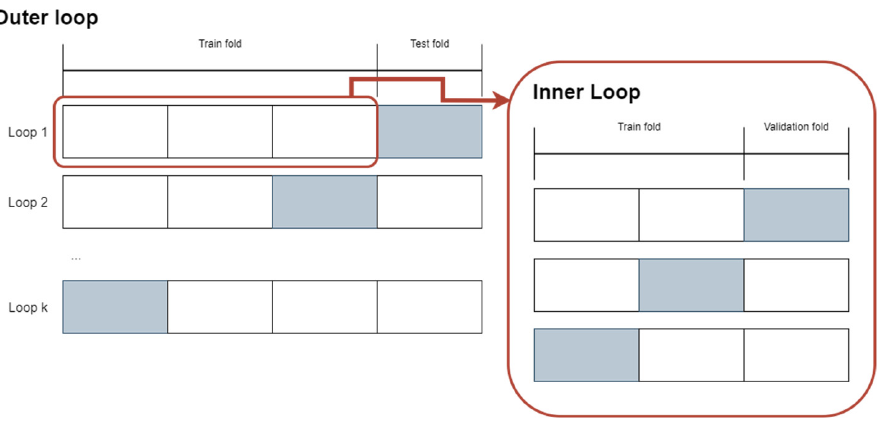
Figure 11. Nested Cross Validation methodology.